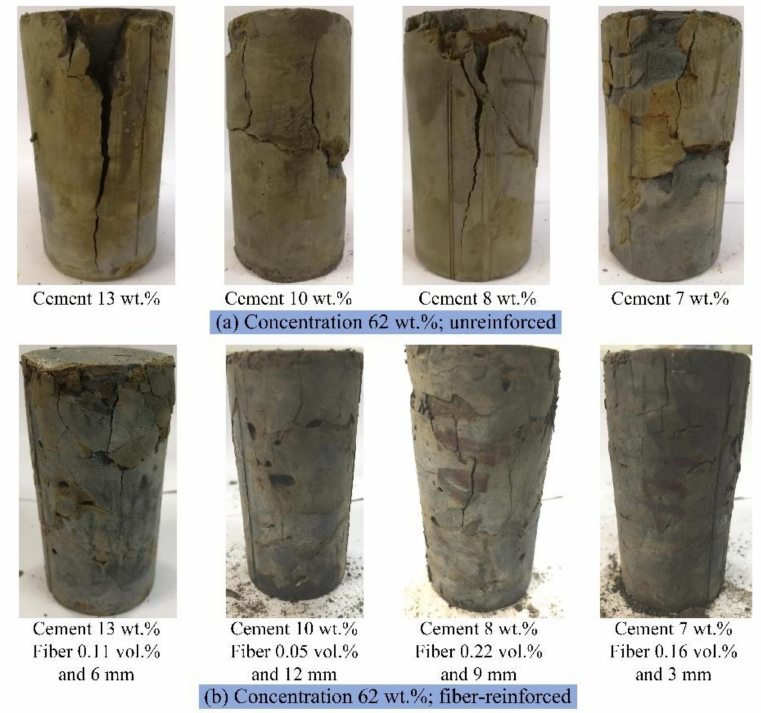
Figure 5. The macroscopic failure modes of the CPB specimens: ( a ) unreinforced with concentration of 62 wt.%; ( b ) fiber-reinforced with concentration of 62